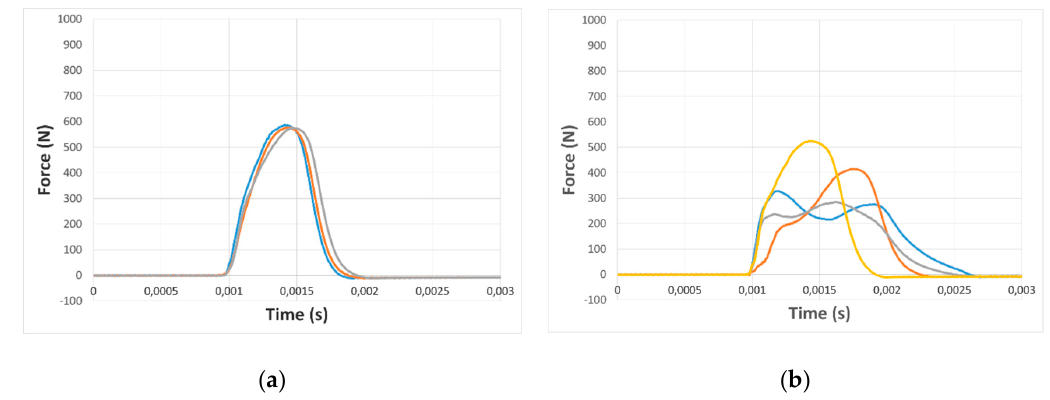
Figure 11. Impact test on Blu room vault: Force–time curve of ( a ) P7 test; ( b ) P4 test.